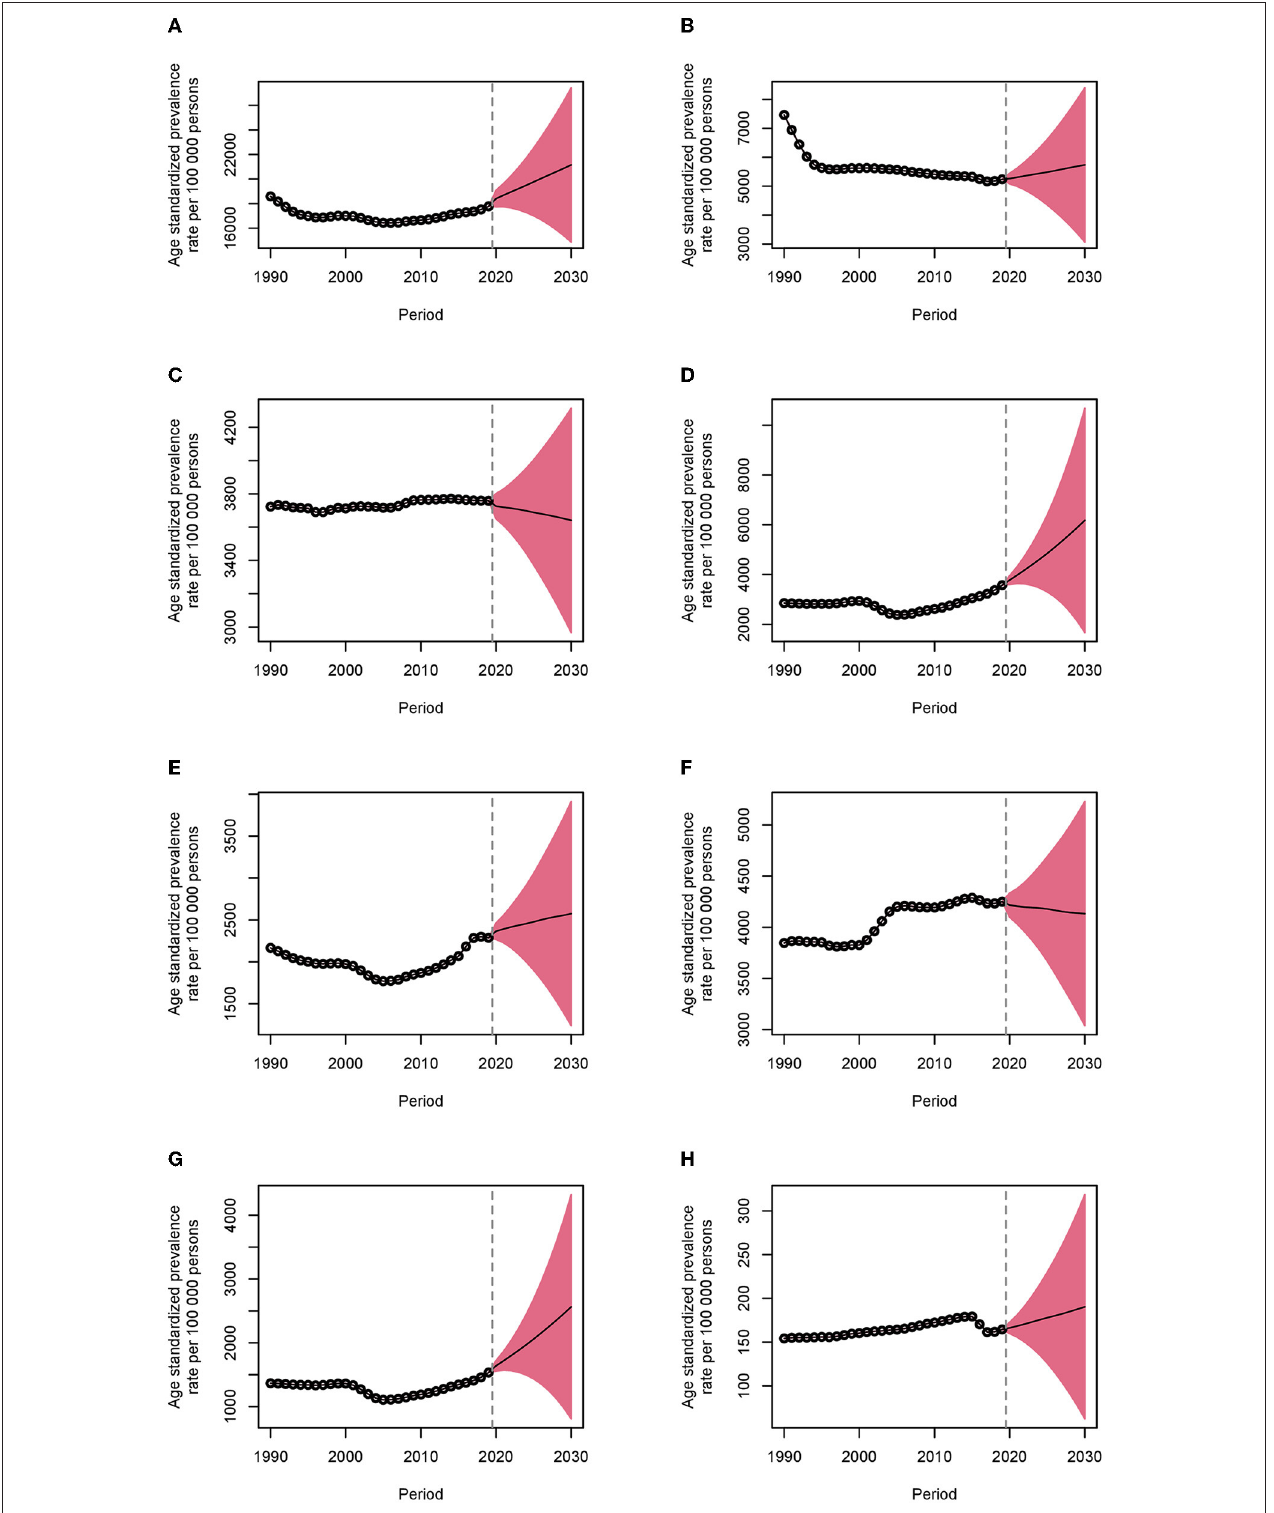
FIGURE 3 | Age-standardized prevalence rates of musculoskeletal rehabilitation needs in China from 1990 to 2030. The dots indicate the observed rates, and the fan plot presents the predicted values with 2.5 and 97.5% quantiles. The solid line indicates the predicted mean values. The vertical dashed line shows when the prediction begins. (A) Musculoskeletal disorders. (B) Low back pain. (C) Neck pain. (D) Fractures. (E) Other injuries. (F) Osteoarthritis. (G) Amputation. (H) Rheumatoid arthritis.